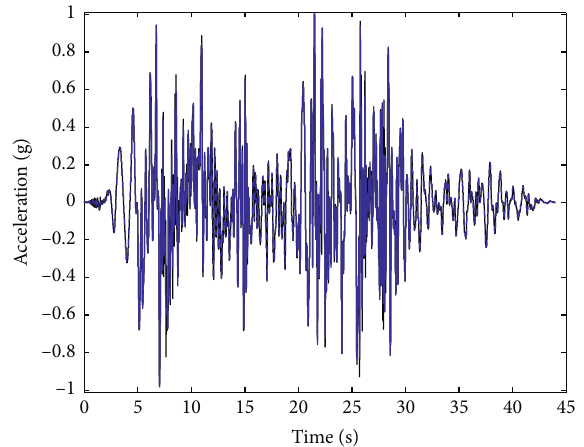
Figure 11: Fitted seismic wave by periodic